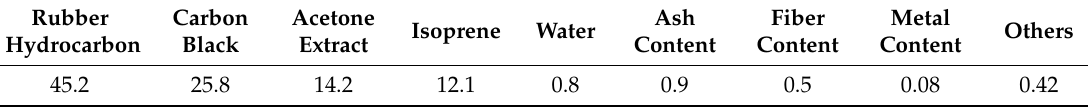
Table 3. Chemical ingredients of crumb rubber (mass fraction